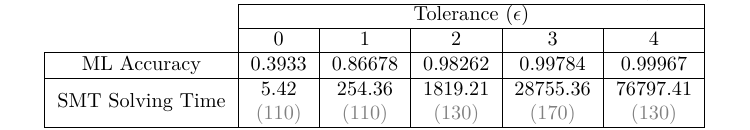
Tolerance ( (cid:15) )